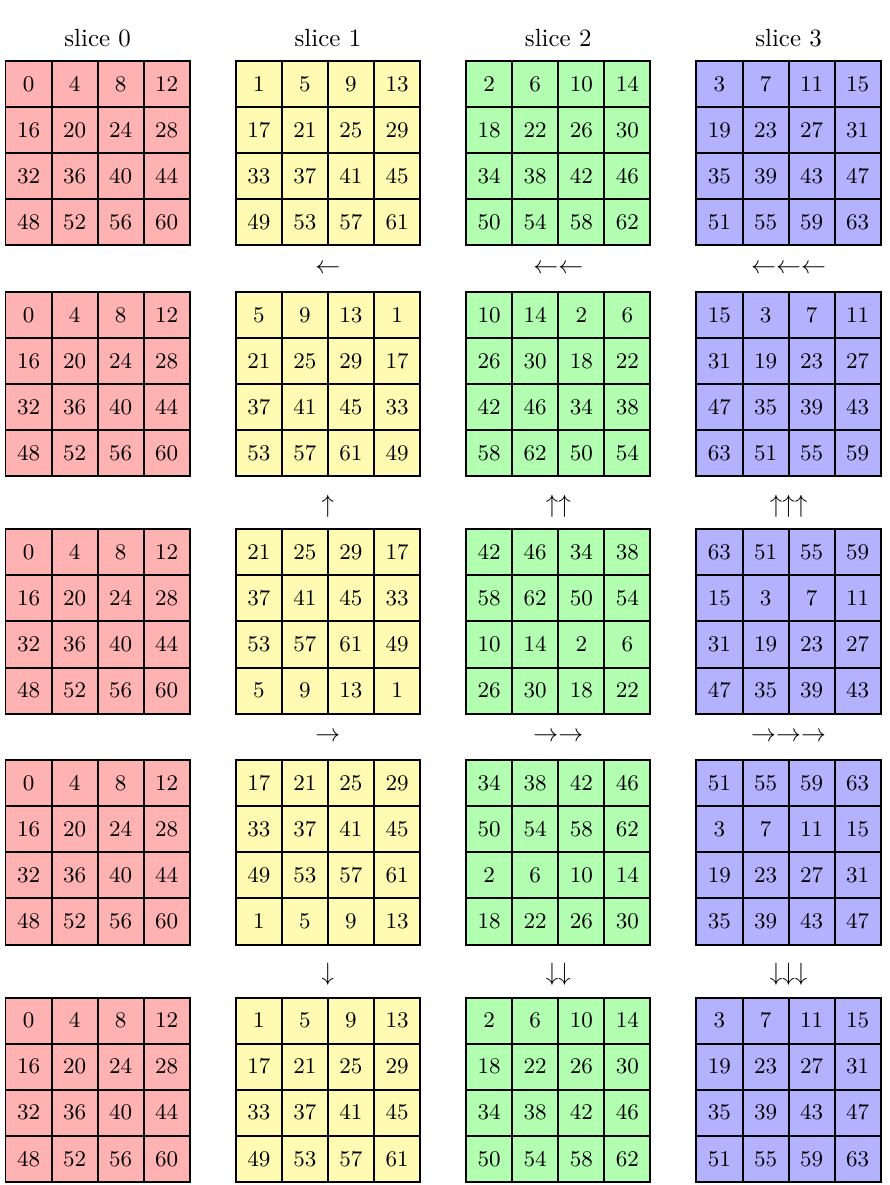
Figure 4: New representation of the GIFT-64 round function during 4 rounds. Each cell represents a bit, and the numbers in the cells then denote the actual index of that particular bit in the state. Slice 0 (resp. 1/2/3) depicted in red (resp. yellow/green/blue) represents all the bits at position 0 (resp. 1/2/3) of the S-boxes of the cipher